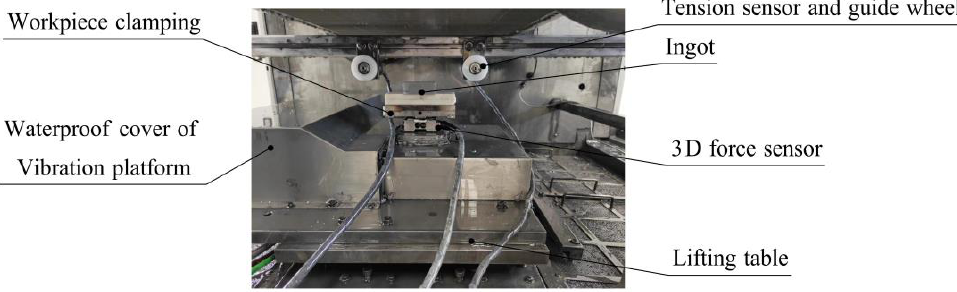
Figure 7. Measurement of experimental parameters.